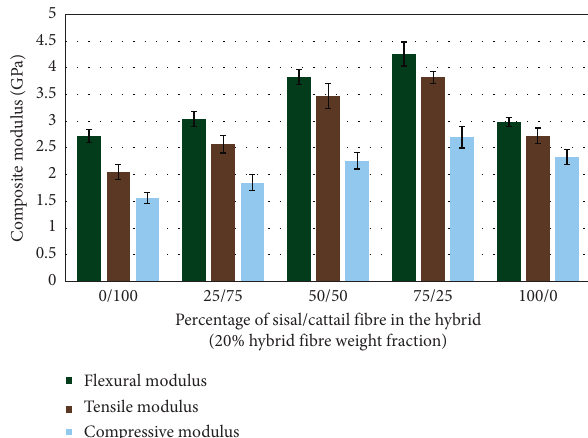
Figure 9: Flexural, tensile, and compressive moduli of hybrid composites at a constant fibre weight fraction of 20%.